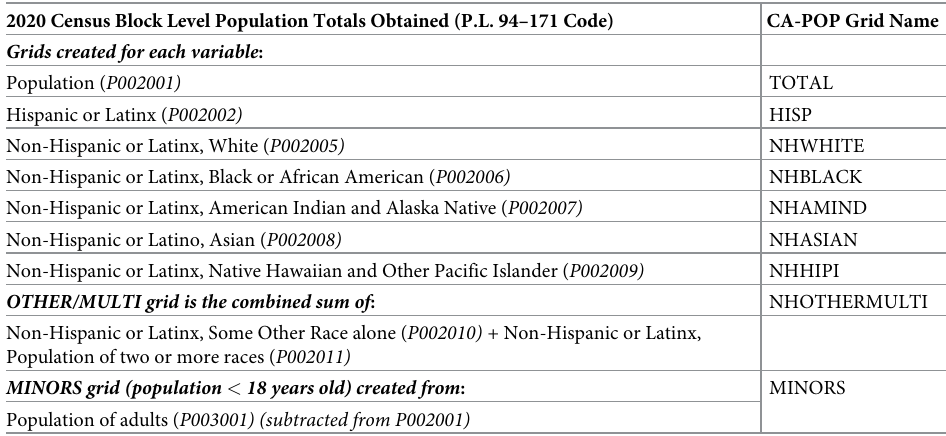
Table 1. Census variables represented as CA-POP